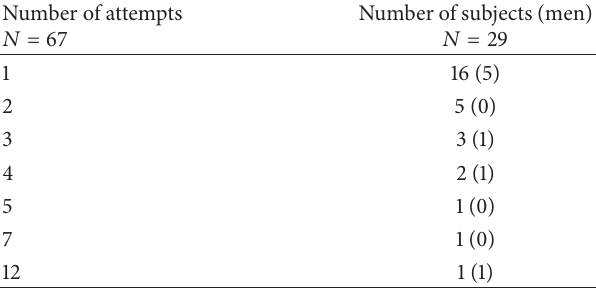
Table 1: Distribution of number of attempts by repetition.